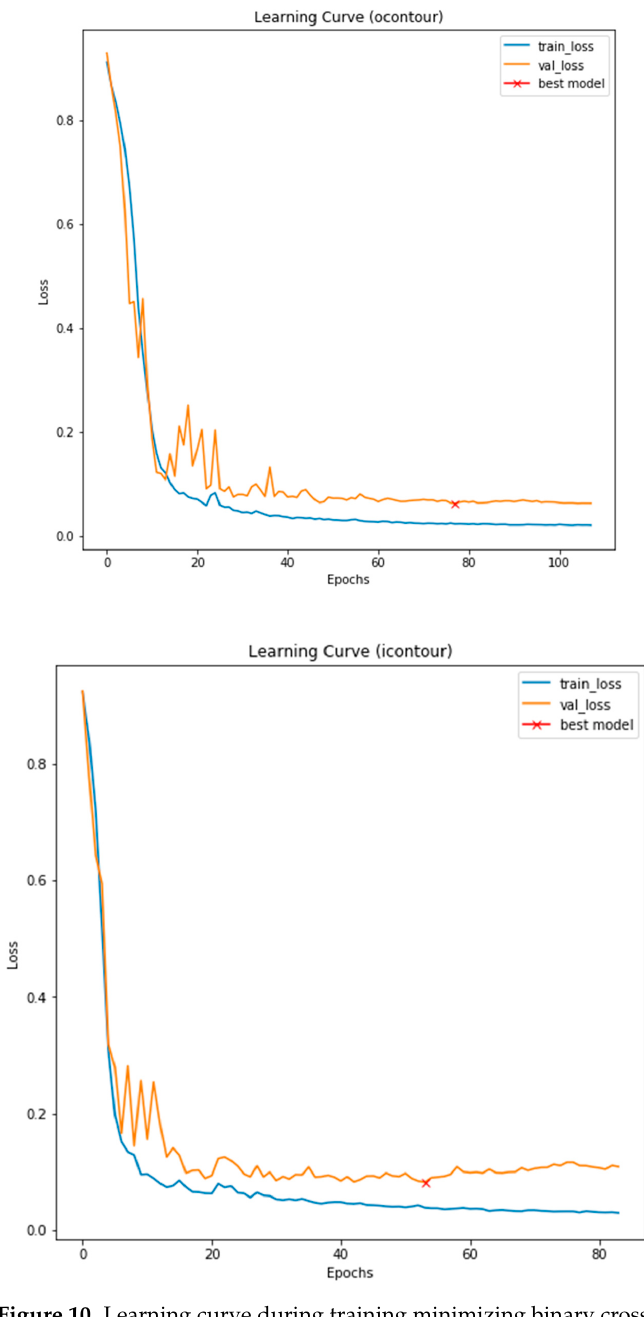
Figure 10. Learning curve during training minimizing binary cross-entropy for epicardium (top) and endocardium (bottom) using the Elu activation. 3.3. Illustrated Results